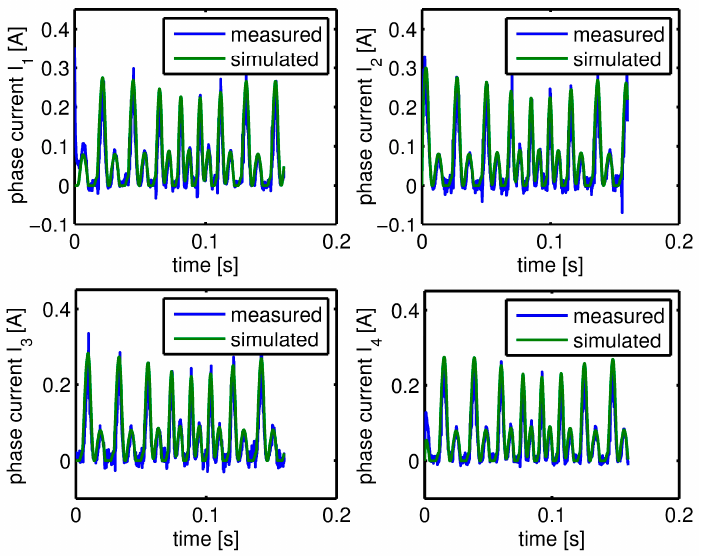
Figure 4. The motor current waveforms for each phase.